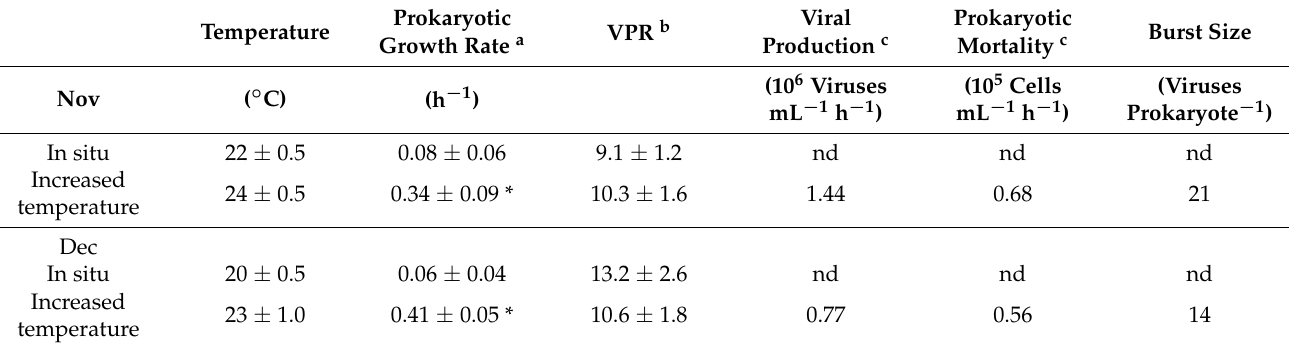
a : Prokaryotic growth was measured during the sampling period in exponential growth phase. b : VPR (virus-to-prokaryotes ratio) in diluted waters was calculated at the end of the experiments. c : Viral production and prokaryotic mortality were estimated using the linear regression between viral and prokaryotic abundance and time between 9 h and 12